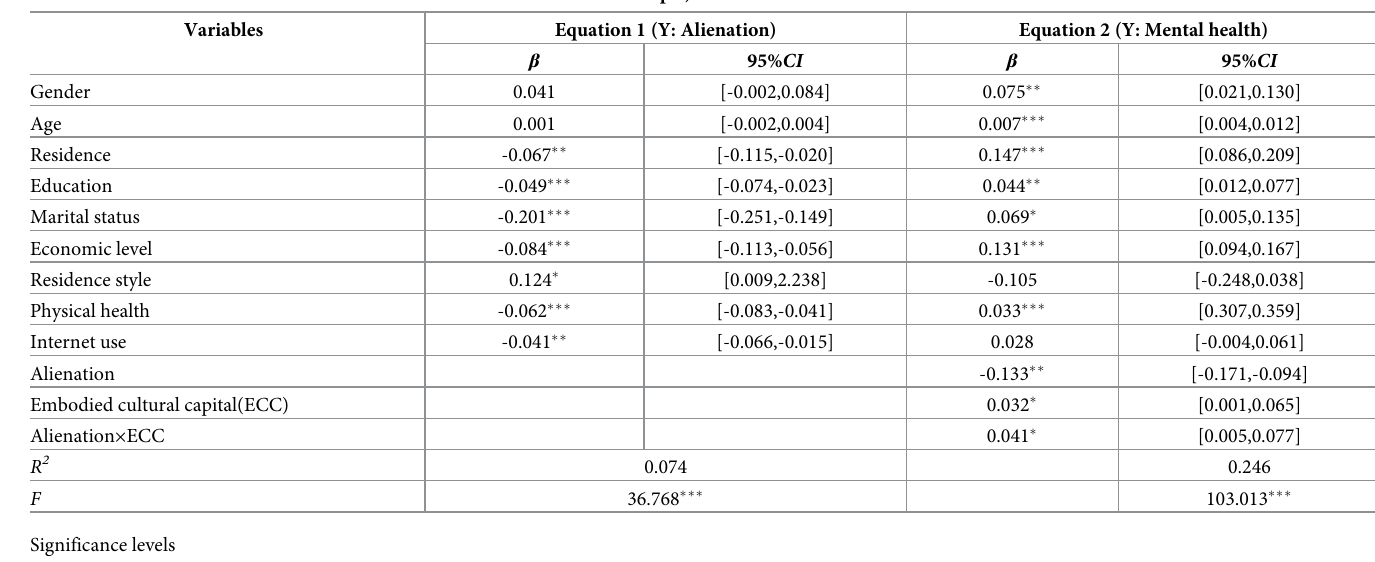
Table 7. Moderated mediation test of Internet use on mental healthFull